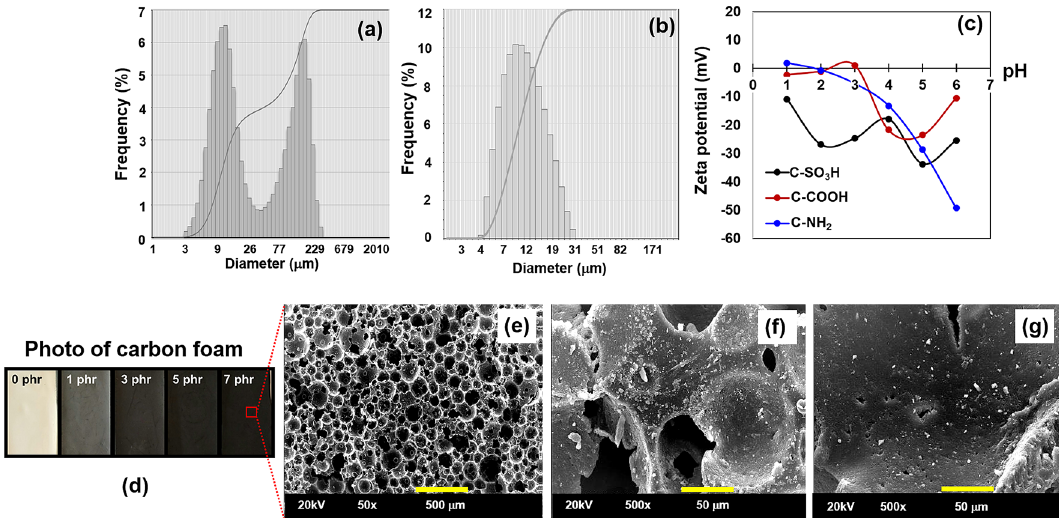
Figure 3. Particle size analysis of (a) activated carbon from coconut shell and (b) carbon slurry. (c) Zeta potential of the functionalised carbon as a function of pH. (d) Photographs taken using a CCD camera. SEM images of the (e) open cell structure of the carbon foam, (f) carbon foam containing unground carbon, and (g) carbon foam containing ground